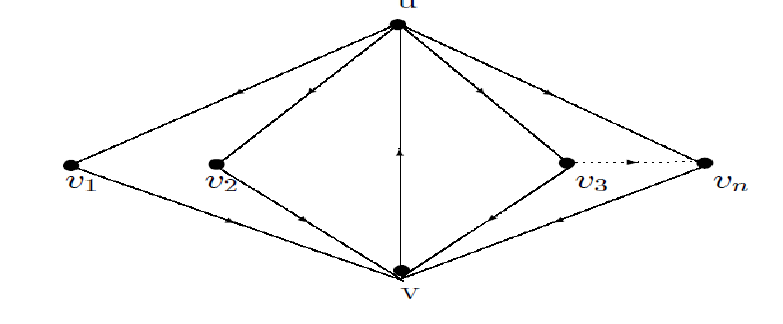
Figure 1.2. Ditriangular Book